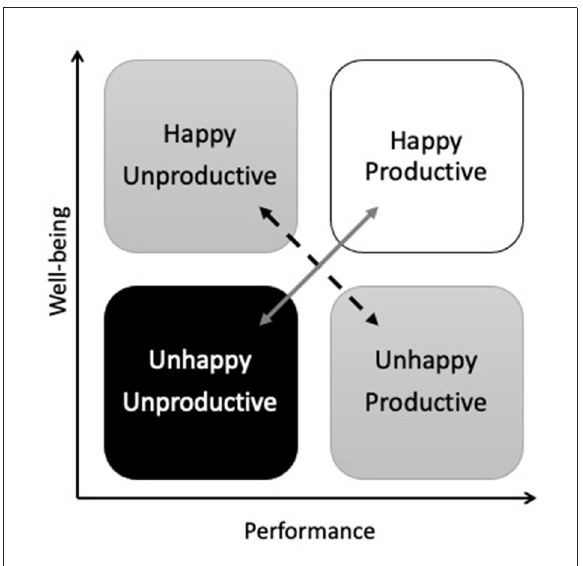
FIGURE1 Four basic interactions between wellbeing and performance